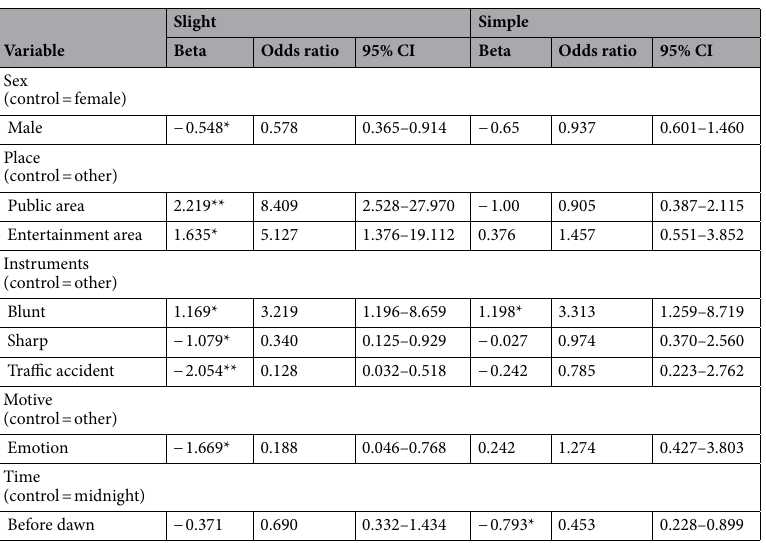
Table 4. Multivariate binary logistic regression model for injury evaluation using only cases with complete information for model variables (N = 2016) (control = grievous injury). CI confidence interval. * P < 0.05, ** P <